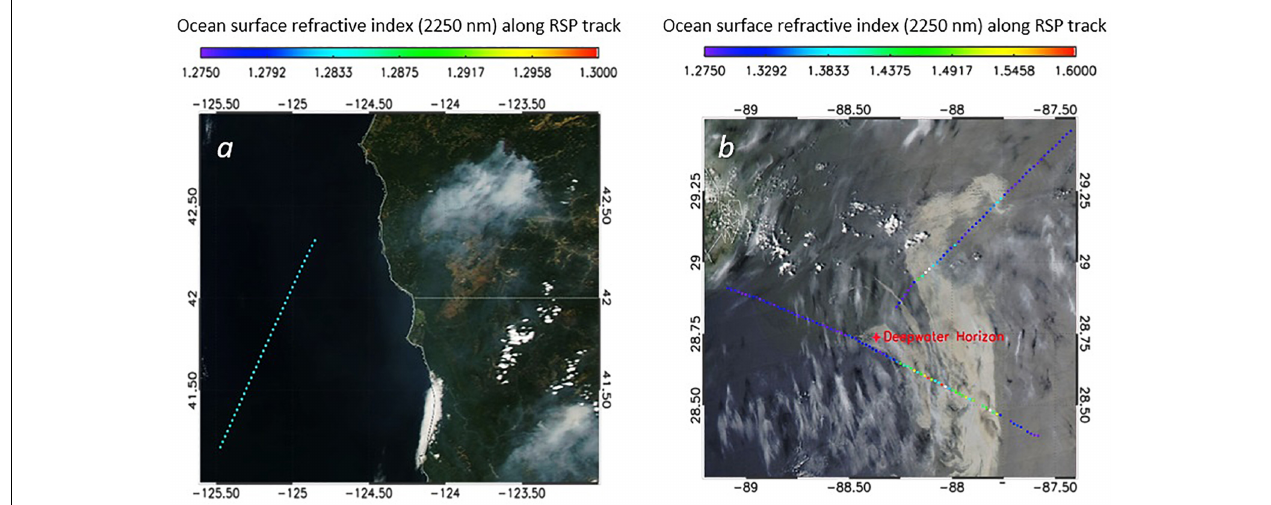
FIGURE 7 | Successful retrievals of the ocean surface refractive index from RSP measurements at 2.2 µ m, over near-real-time imagery from the MODIS sensor. (a) SEAC4RS campaign (08/02/2013): test flight over pure seawater. Note that the color bar covers for this panel only a small range of the refractive index. (b) CARES/CalNEX campaign (05/11/2010): transects intersecting the oil spill caused by the explosion of the Deepwater Horizon offshore platform. The refractive index of pure seawater at 2.2 µ m measured in laboratory experiments by Segelstein (1981) is 1.2815.